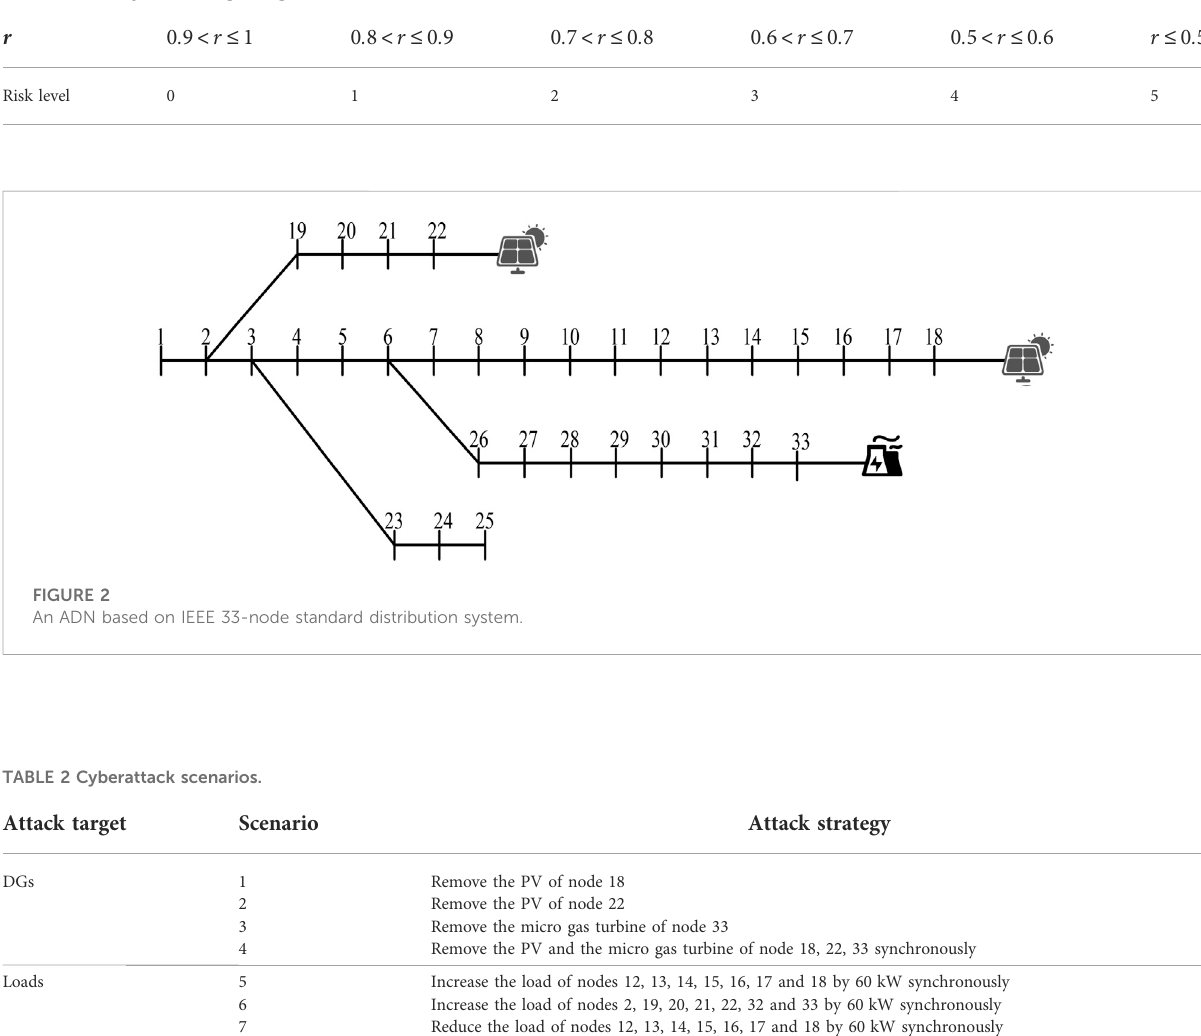
TABLE 1 Security risk level grading of ADNs situations.